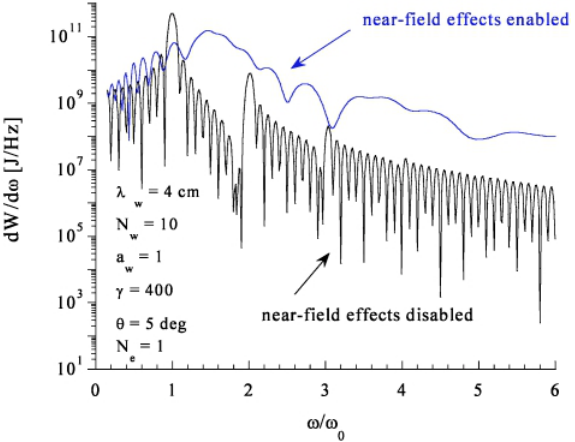
FIG. 6. (Color) Energy spectrum for a Gaussian bunch distribu- tion. The electron bunch has an rms length s z (cid:1) 100 m